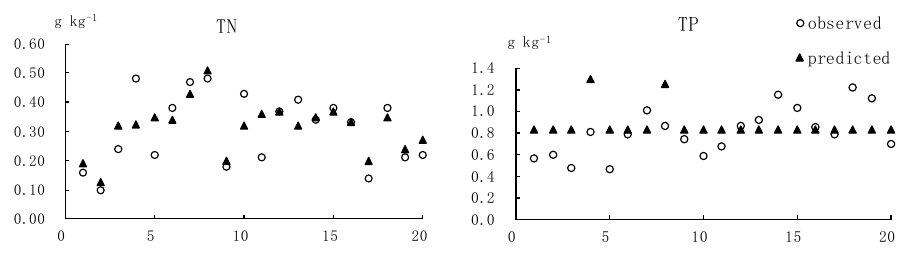
Figure 2. Comparison of observed and predicted value of soil properties.